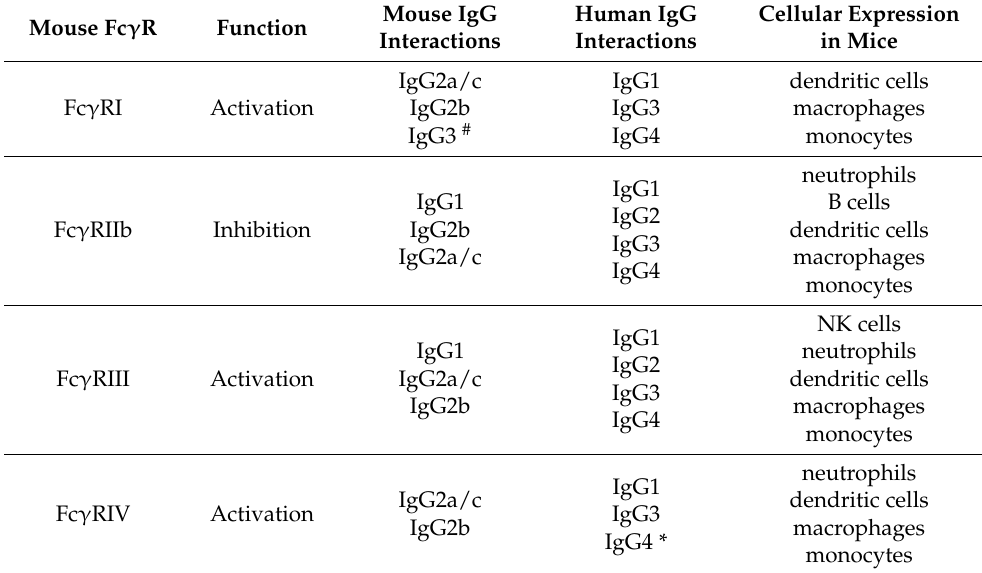
Table 1. Summary of signaling function, mouse and human IgG interactions, and cell type expression of mouse Fc γ